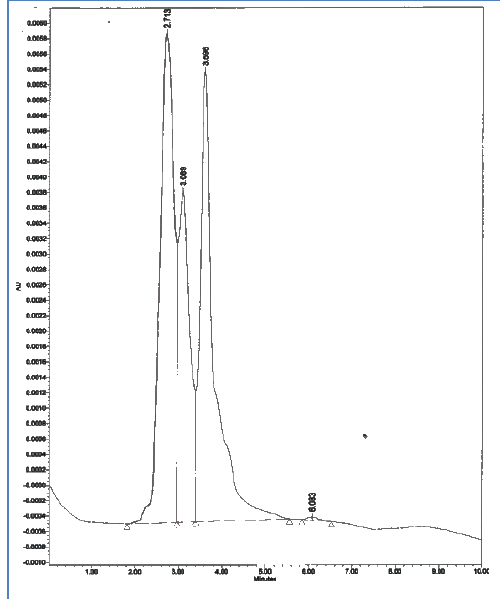
Figure (2): -HPLC of ethyl acetate fraction.